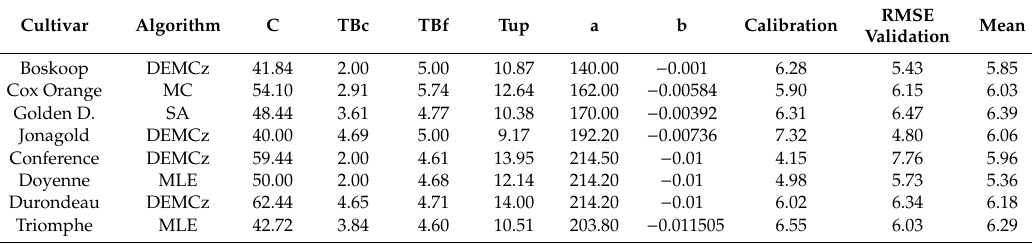
Table A1. Parameters from optimisations with the lowest RMSE phase, continuous model. The RMSE values are given separately for the calibration and validation sets. The mean column gives the mean of both sets.